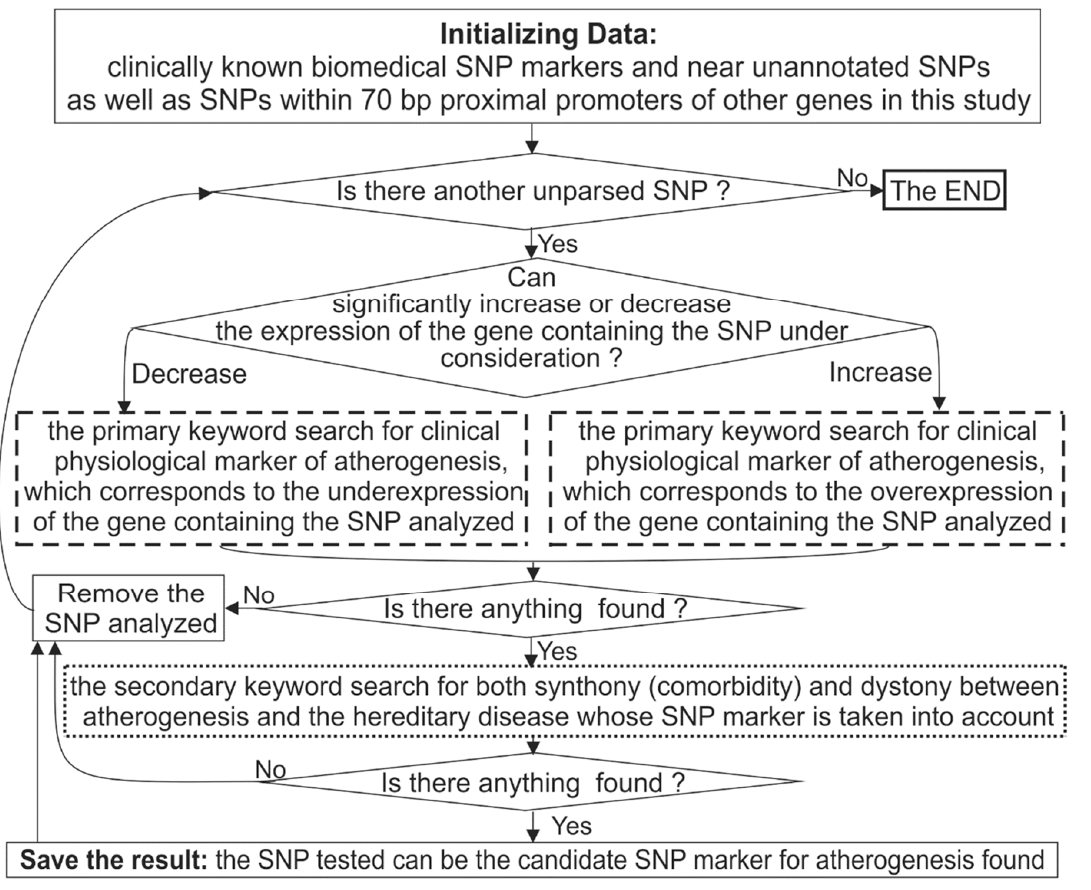
Figure 4. A flow chart of the keyword search for atherosclerosis as a comorbidity of hereditary diseases whose candidate SNP markers can alter TBP-sites in the human gene promoters.